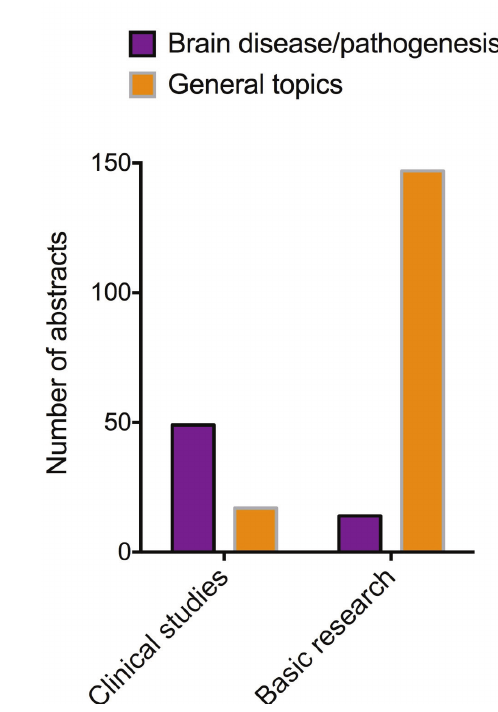
Fig. 2 - General distribution of research activity in the area of Cryptococcus and cryptococcosis. Abstracts presented in the most recent international conference on Cryptococcus and cryptococcosis (May 2014, Amsterdam) were individually analyzed and classified into general topics or brain disease and/or pathogenesis. This analysis revealed that studies on brain disease predominated in the clinical area, which probably reflects the fact that meningitis and meningoencephalitis are the most serious clinical conditions in human cryptococcosis. In basic research, however, studies on brain disease and/or pathogenesis composed a minor fraction of scientific